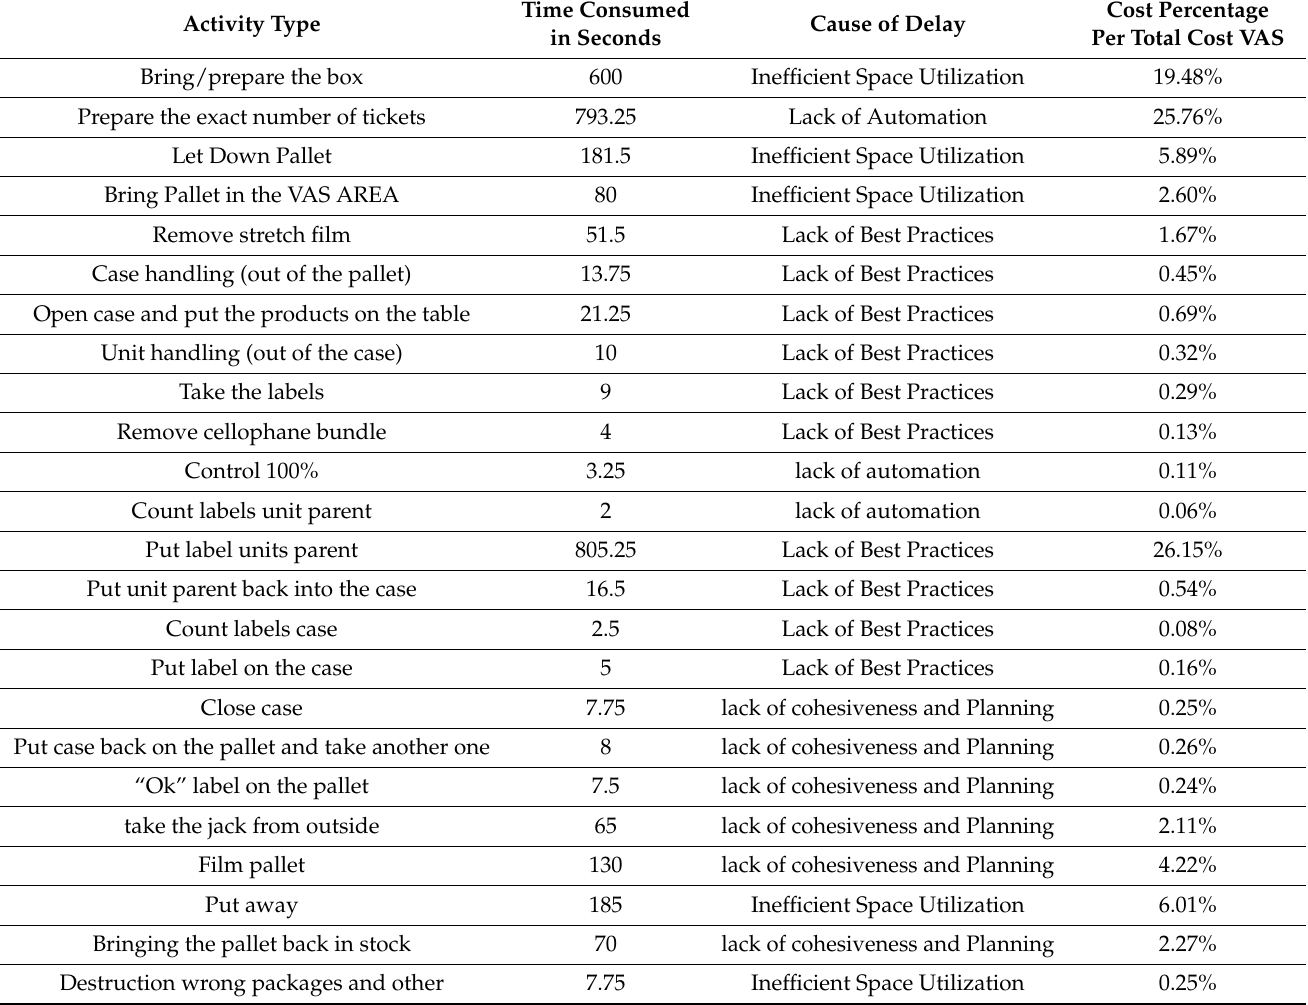
Table 3. Analysis of narcotic